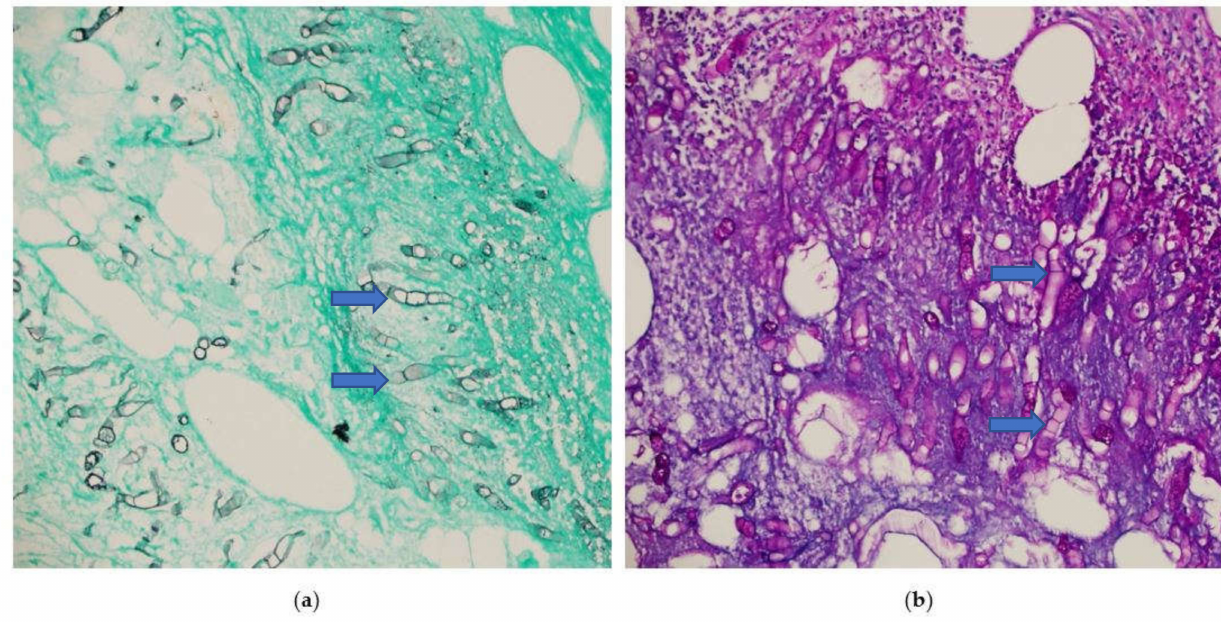
Figure 3. Microscopic sections of the colonic specimen, ( a ) Grocott methenamine silver (blue arrow) (GMS), ( b ) periodic acid-Schiff (PAS) stains shows fungal hyphae that look large, broad, and irregular with sparse septa and thin walls (blue arrow). (Magnification ×